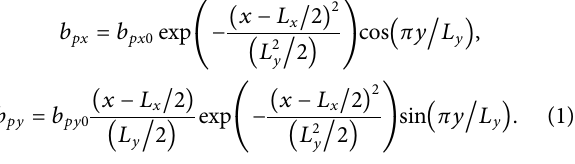
Frontiers in Astronomy and Space Sciences |